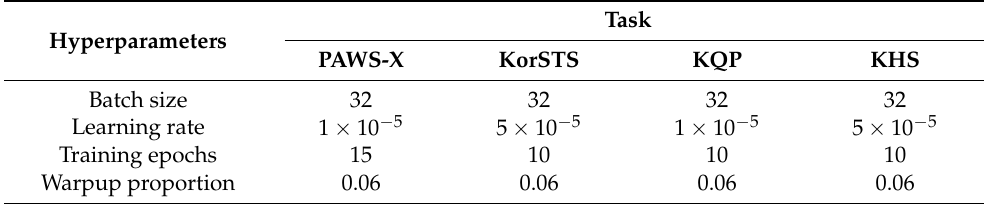
Table A2. Hyperparameters used for downstream